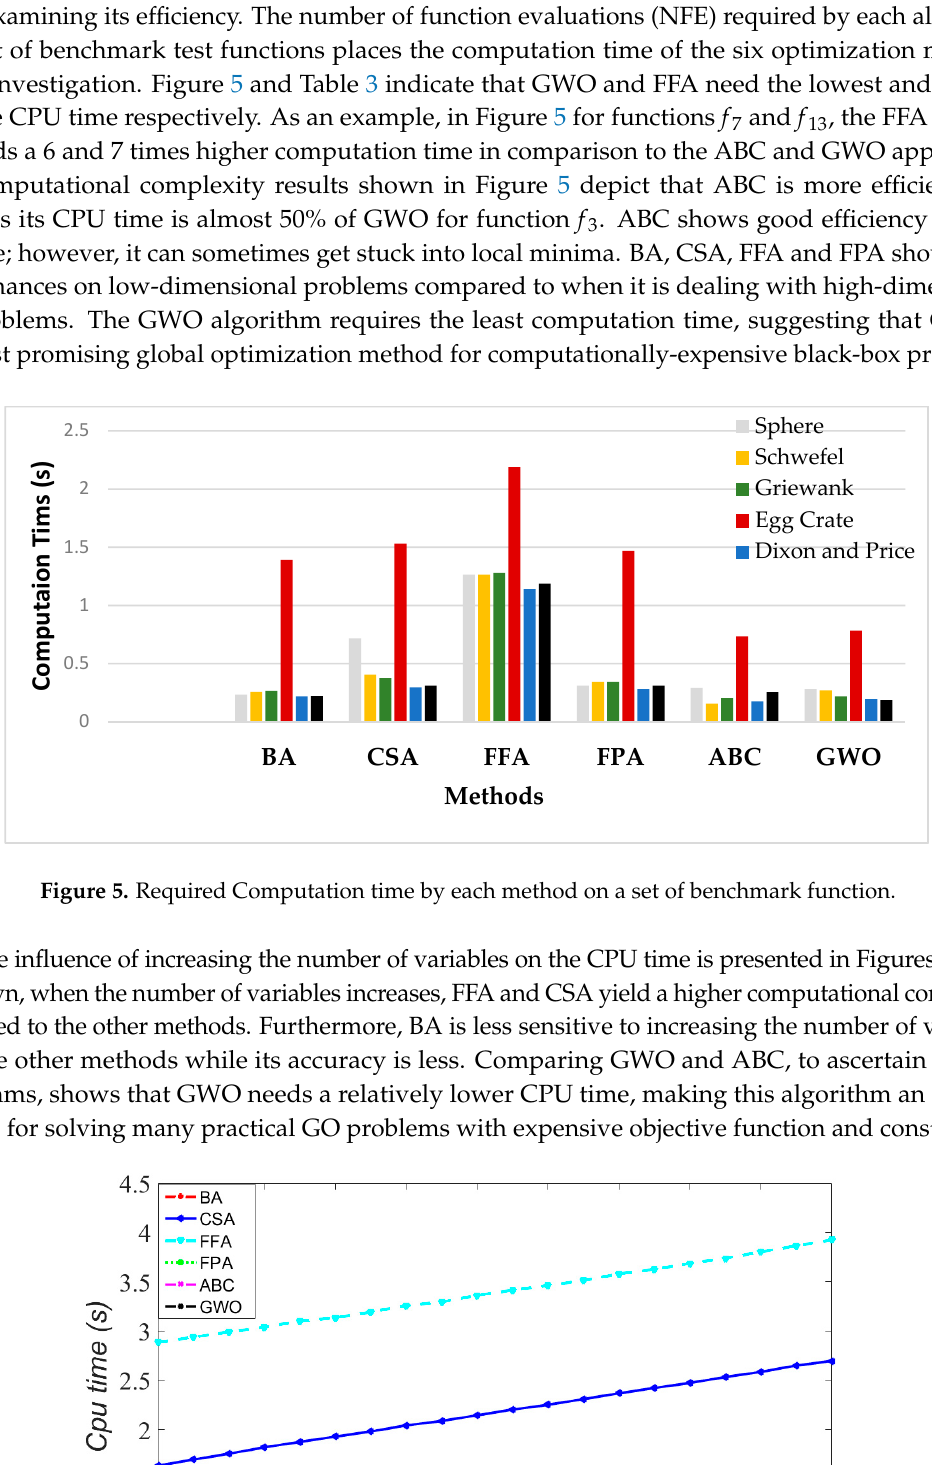
Figure 7. Impact of increasing number of function dimensions vs. CPU time for Dixon and price function. 6.3. The Impact of Increasing the Number of Variables on the Performance The aim of this section is to study the impact of high dimensionality on the reliability and accuracy of the solutions achieved by the tested optimization algorithms in solving computationally- expensive complex optimization problems. Figures 8–10 compare the performance of these six methods for the Sphere, Griewank and Dixon and Price functions. The horizontal axis shows the number of variables, and the vertical axis shows the objective function’s error value at a fixed number of function evaluations. Similarly, the value obtained in each iteration serves as a performance indicator. As illustrated, increasing the number of variables leads to the degradation in the performance of BA and FPA. This is owing to the fact that the exploitation capability of BA is comparatively low-especially for high- dimensional problems. The results also reveal that FPA is only efficient in handling low-dimensional expensive black-box functions design problems (less than 10 design variables). On the other hand, GWO and ABC are not as sensitive as the other methods in handling high-dimensional problems regardless of the complexity and the surface topology of the tested problem. Figures 8–10 show that the performance of the GWO and ABC algorithms, which is related to capability and efficiency, is superior for high-dimensional problems. Figure 10 illustrates